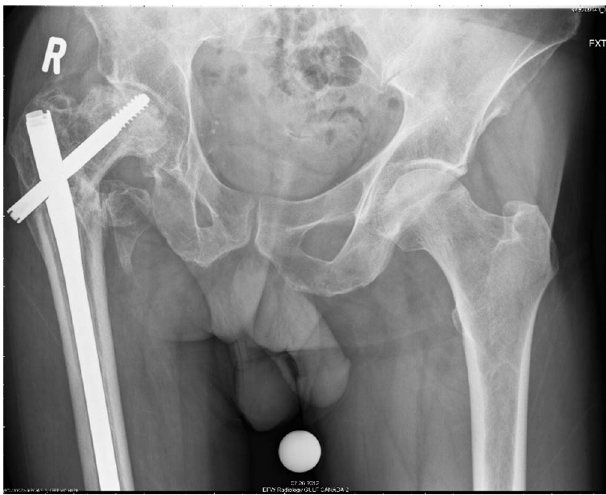
Figure 1. Painful right hip with collapse of the femoral head due to avascular